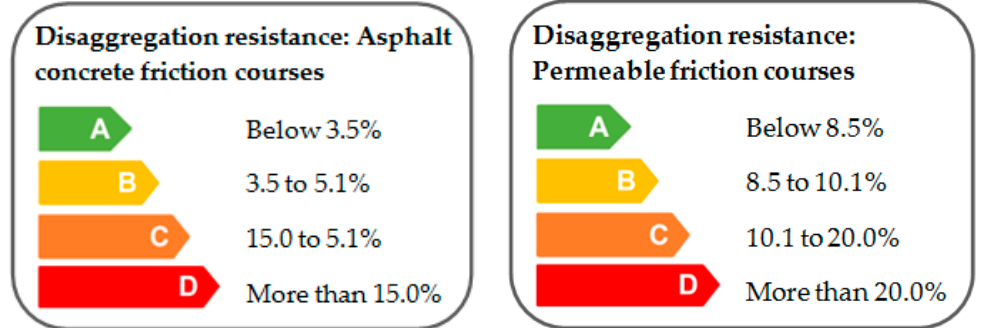
Figure 14. Disaggregation resistance labels based on the type of mixture. Appl. Sci. 2019 , 9 , 1694